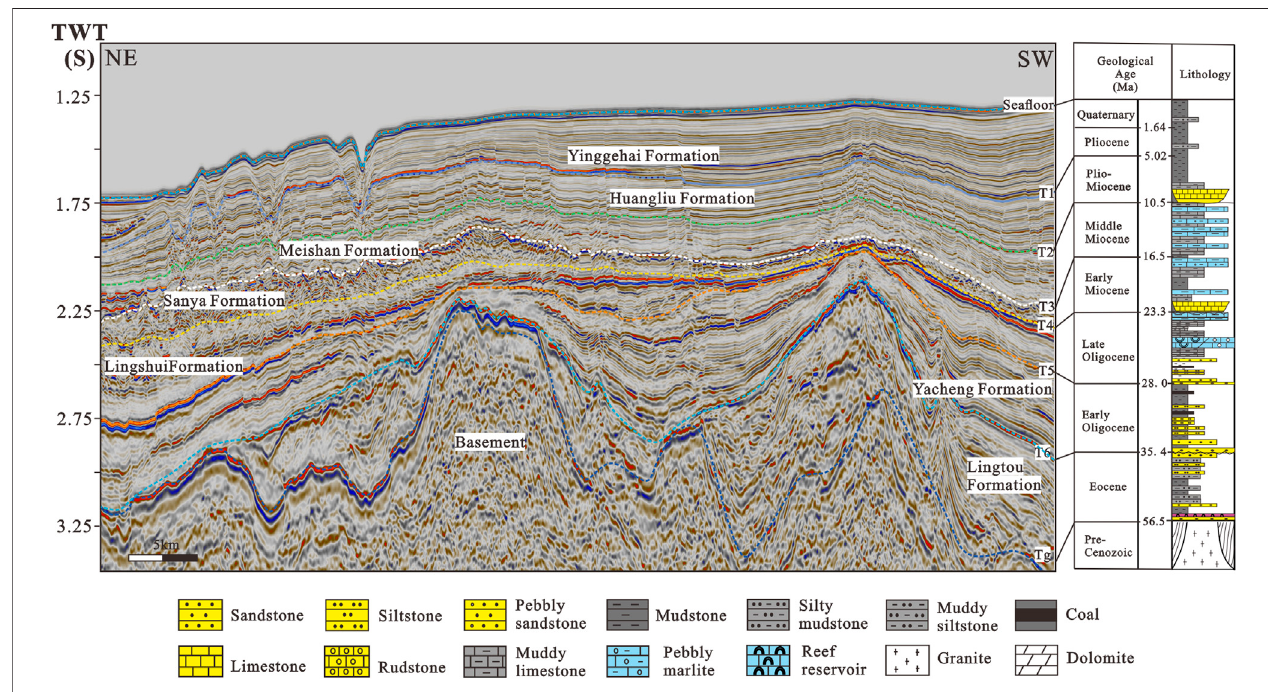
FIGURE 2 | Schematic stratigraphic sequences in the Zhongjiannan basin and the main seismic horizons (modifed after Xie et al., 2006; Lu et al., 2017).